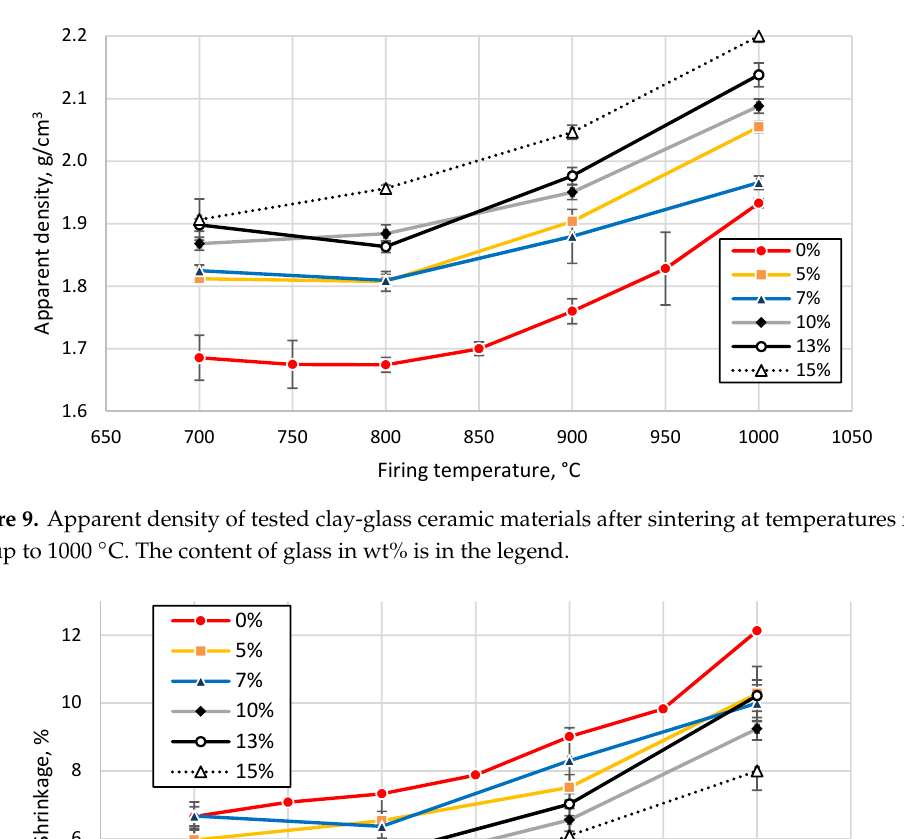
Figure 9. Apparent density of tested clay-glass ceramic materials after sintering at temperatures from 700 up to 1000 °C. The content of glass in wt% is in the legend.